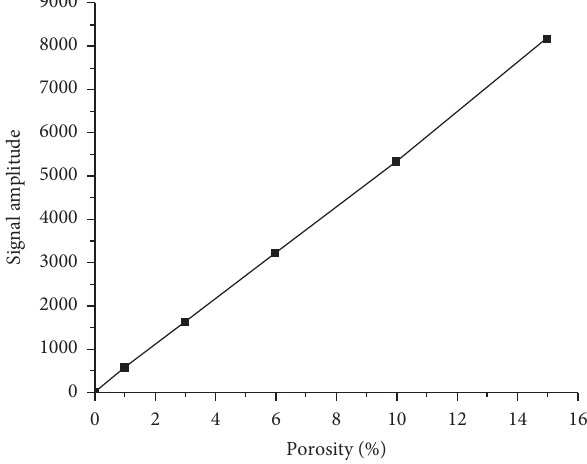
Figure 4: The experimental standard sample. (a) Oil sample. (b) Porosity standard. Table 3: CPMG sequence parameters.